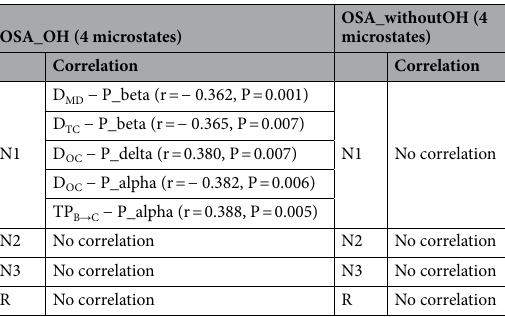
Table 6. Correlation between microstate parameters of 4 microstates and power, sample entropy and DFA in OSA_OH and OSA_withoutOH patients (P < 0.05/7, i.e., 7 being the number of microstates and power, sample entropy and DFA).